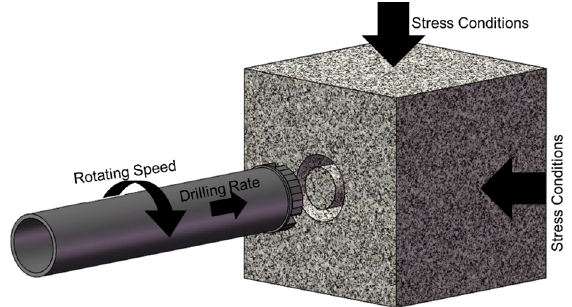
Figure 4. Drilling test.